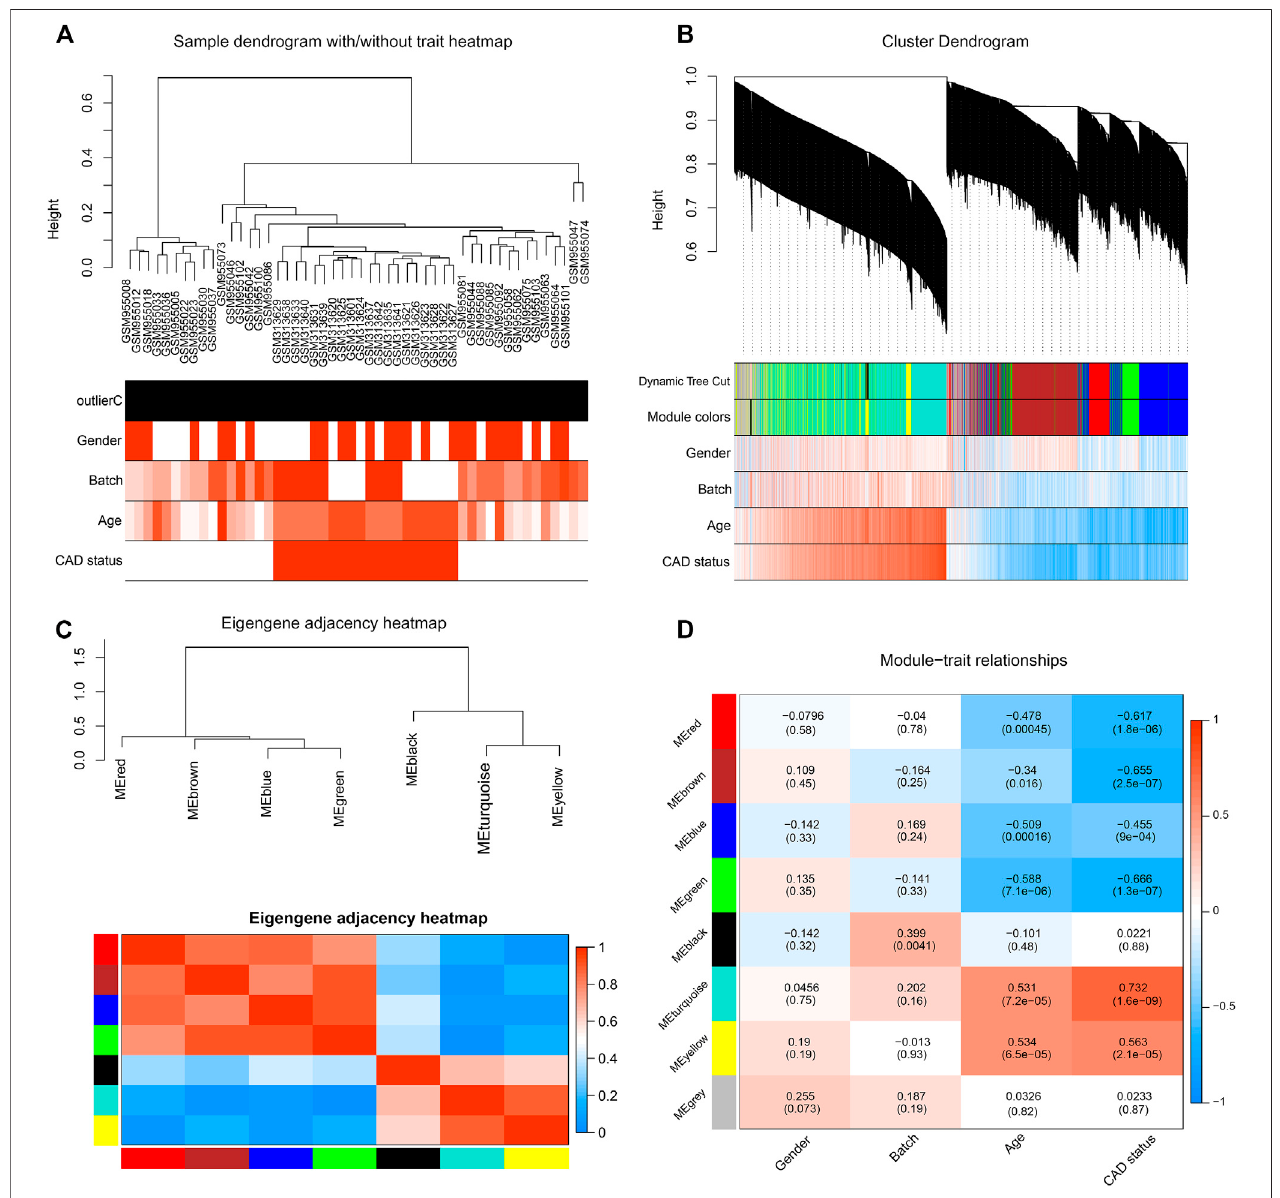
FIGURE 1 | Identi fi cation of signi fi cant modules in coronary artery disease (CAD) heart tissue with weighted gene co-expression network analysis (WGCNA). (A) Sample dendrogram and clinical trait heatmap. Fifty samples were clustered according to clinical traits, such as gender, batch, age, and CAD status. Gender: red denotesmale; white ,female.Ageandbatch:discretevaluesarerepresentedwithcolordepthpositivelycorrelatedwitheachsample.CADcondition: red representsCAD patients; white represents healthy controls. (B) Cluster dendrogram and gene – trait association heatmap obtained from the transcriptome data of GSE12504 and GSE22253 with average hierarchical linkage clustering. The color row below the dendrogram denotes the assigned modules allocated by dynamic tree cutting and mergedmodulefunction. Blue and redcolors representanegativeandapositivecorrelationbetweenageneandclinicalfeatures,respectively. (C) Eigengeneadjacency heatmapshowingextramodularconnectivityamongallthemodules.Intheheatmap,each row and column correspondtoamodule. Cyan to blue denoteslowermodule connection ( < 0.5); progressively darker red denotes higher connection ( ≥ 0.5). Colored squares along the vertical and horizontal sides correspond to modules. (D) Heatmapshowingthemodule – traitcorrelation.Hierarchicalclusteringofeigengenesrepresentsthemodules.Each row denotesthemodule,whileeach column denotes the feature of CAD. Values in the box represent the correlations and corresponding p -values.